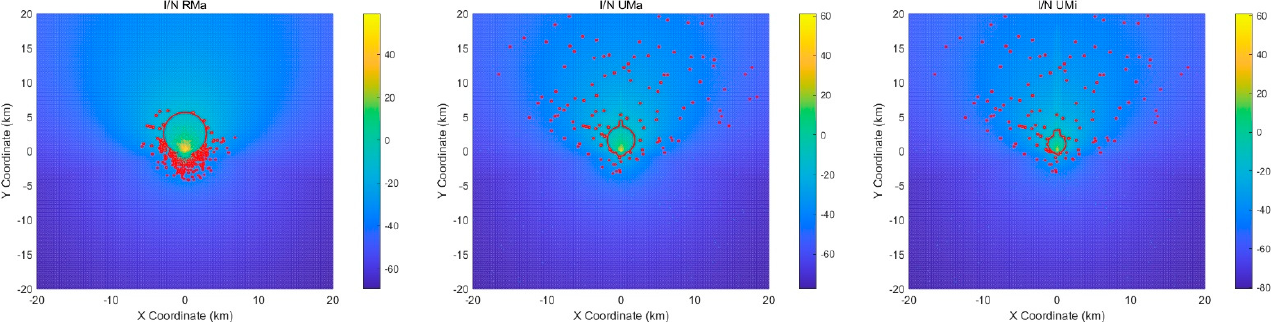
Figure 21. RMa, UMa, and UMi scenarios with an ES antenna elevation angle of 48° for a 4 × 4 antenna array.